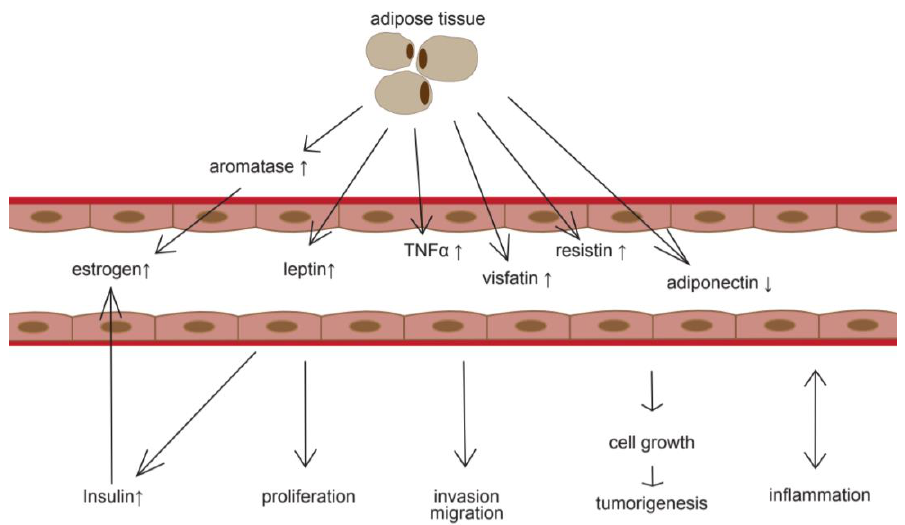
Figure 2. Simplified mechanisms of adipose tissue influence on tumorigenesis.